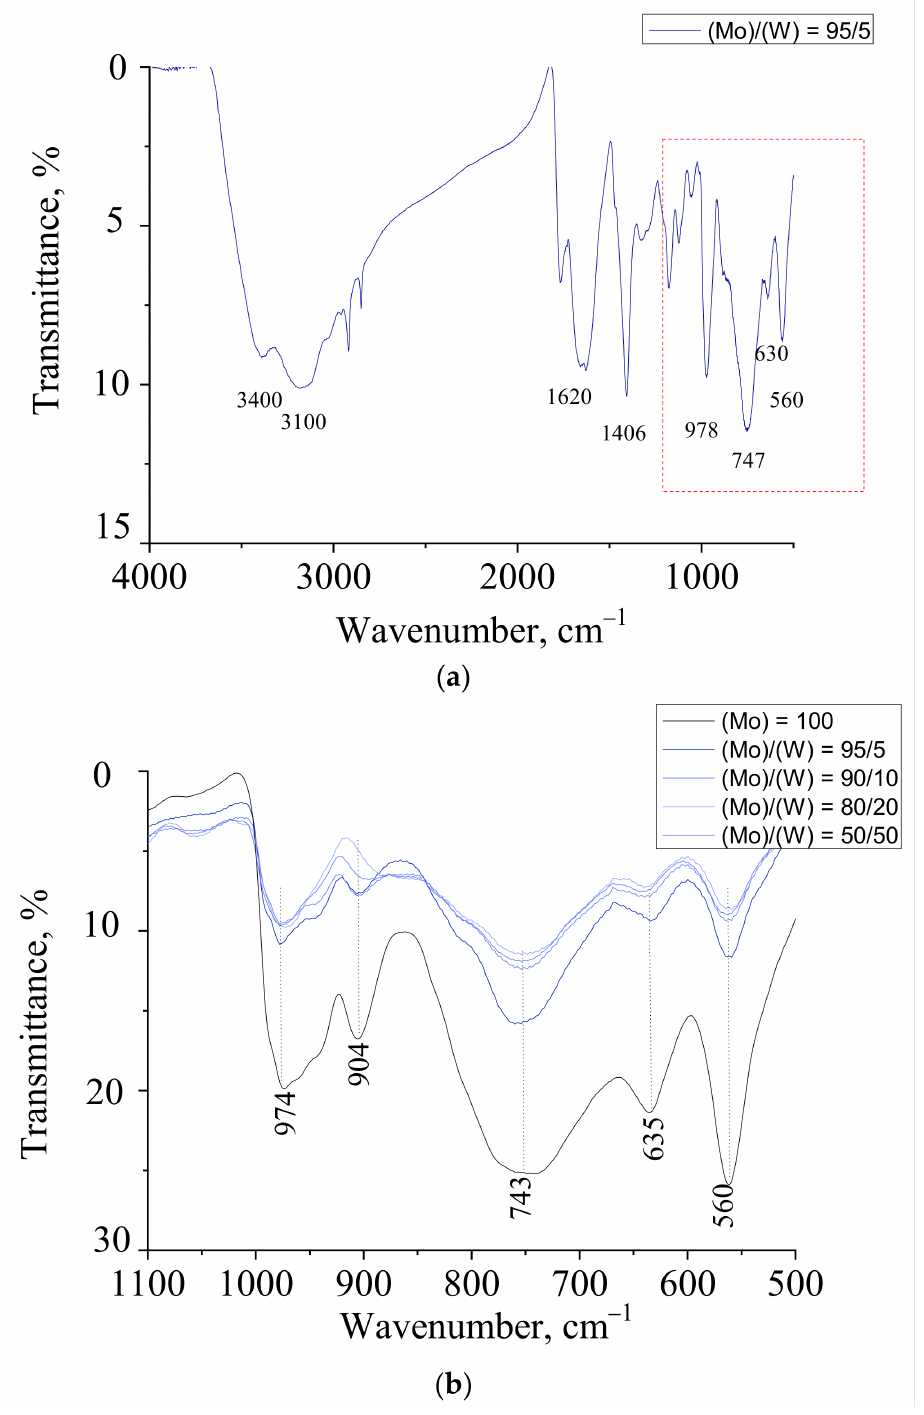
Figure 4. FTIR spectra of molybdenum–tungsten oxide nanoclusters with different molar ratios (Mo)/(W) isolated from the dispersions synthesized: ( a ) general spectrum (500–4000 cm − 1 ) for sample (Mo)/(W) = 95/5 and ( b ) spectra (500–1100 cm − 1 ). In the region of 1000–500 cm − 1 , there were bands that characterize polyoxometalate structures, including molybdenum oxide nanoclusters. For all samples of molybdenum– tungsten blues obtained with the molar ratio of the initial precursors (Mo)/(W) = 95/5; 90/10; 80/20; and 50/50, bands at 977, 902, 737, 634, and 561 cm − 1 were observed, cor- responding to the structure of toroidal complexes of the cluster family Mo 154-x